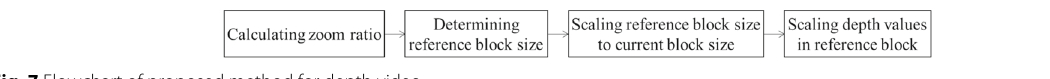
Fig. 7 Flowchart of proposed method for depth video